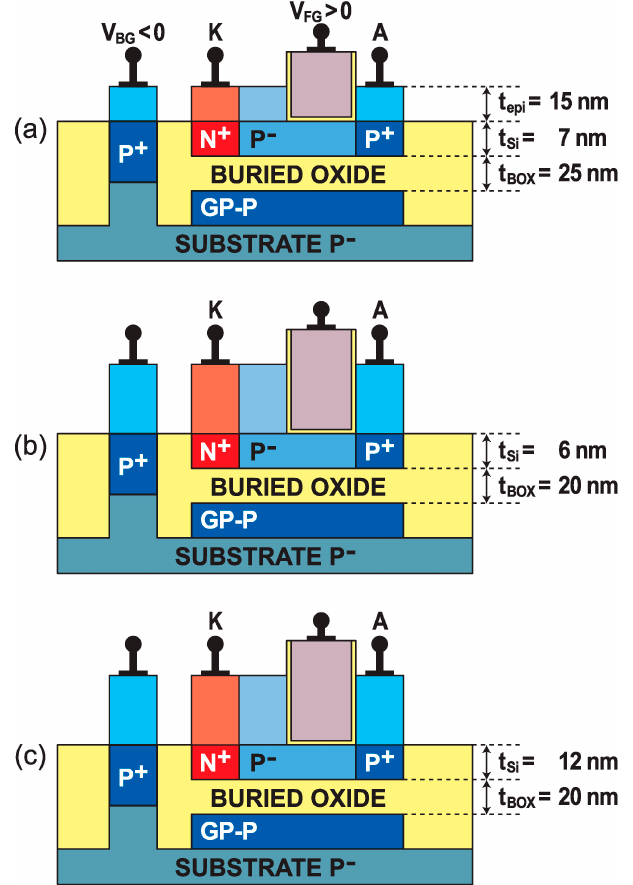
Figure 4. Cross-section views of Z 2 –FETs fabricated with FD-SOI technologies: ( a ) 28 nm node, ( b ) thin 14 nm node, and ( c ) thick 14 nm node. After completion of the second spacer, the anode and the cathode are implanted with boron and phosphorus (10 20 cm − 3 ), respectively. An epitaxial layer (t epi = 15 nm) is grown on the whole structure, to reduce series resistance. A final step, before contact formation, consists in covering the ungated region with an oxide layer (RPO), preventing silicidation.